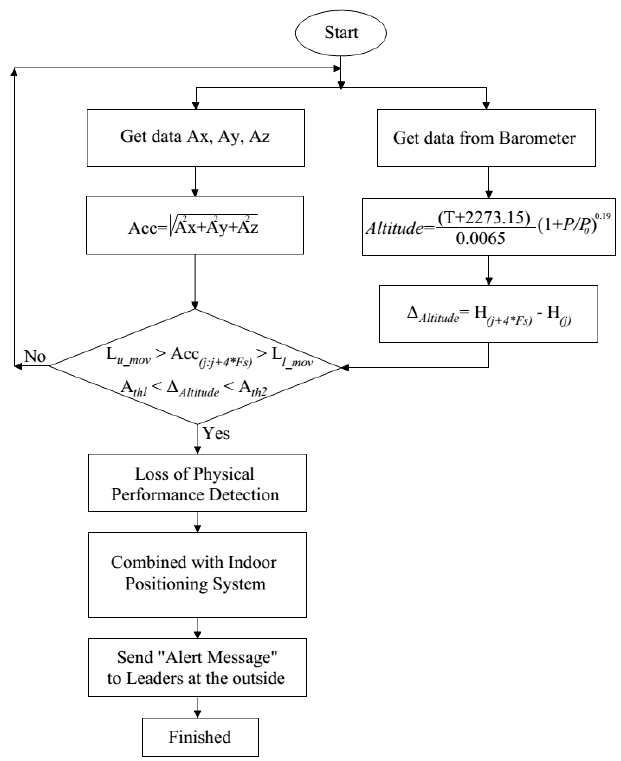
Figure 8. The loss of physical performance detection algorithm.